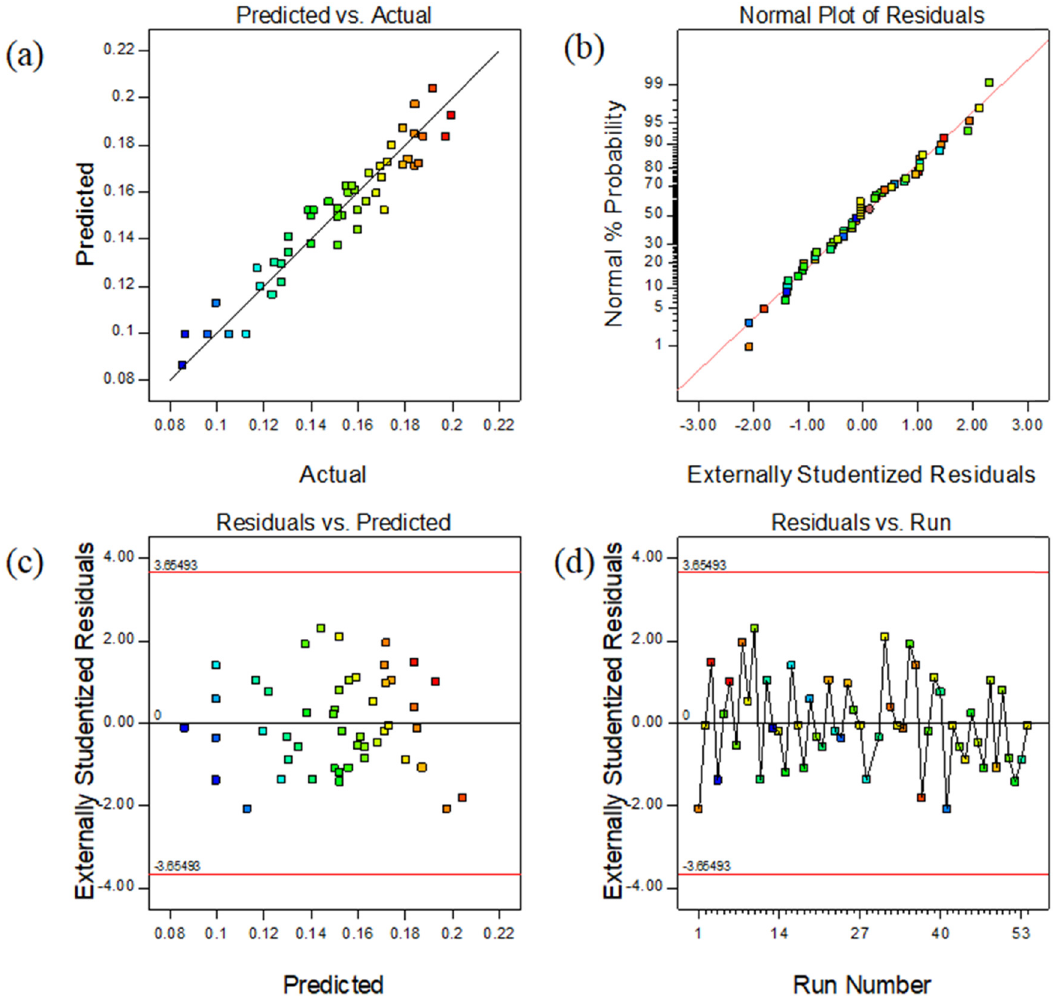
Figure 5: ( a ) Predicted vs experimental temperature; ( b ) normal% probability and externally studentized residual plot; ( c ) externally studentized residuals vs the predicted temperature; and ( d ) outlier t